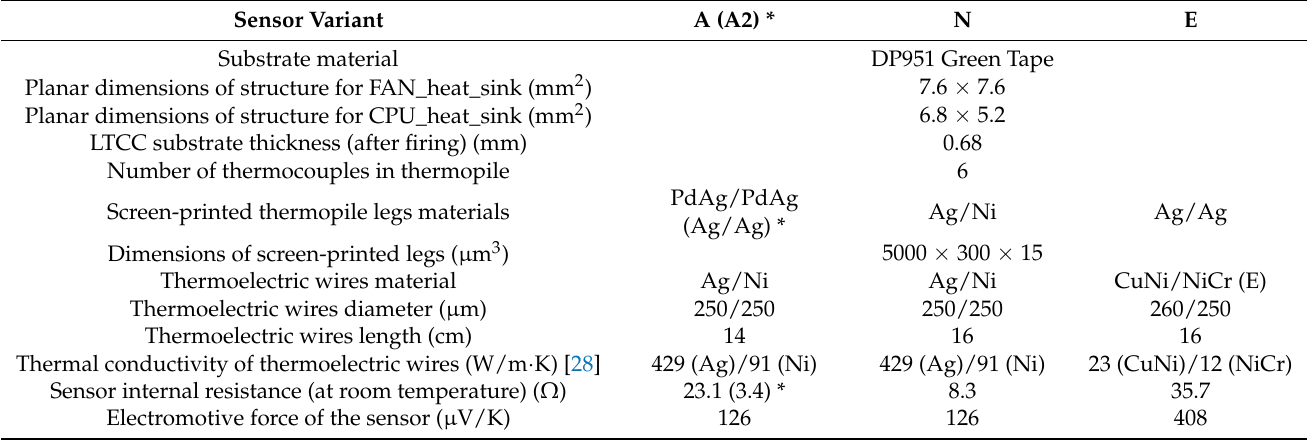
Figure 13. The final structure: ( a , c ) LTCC substrate for FAN_heat_sink; ( b ) LTCC substrate for CPU_heat_sink; ( d ) thermoelectric temperature difference sensor. Table 1. Basic parameters of fabricated and investigated thermoelectric